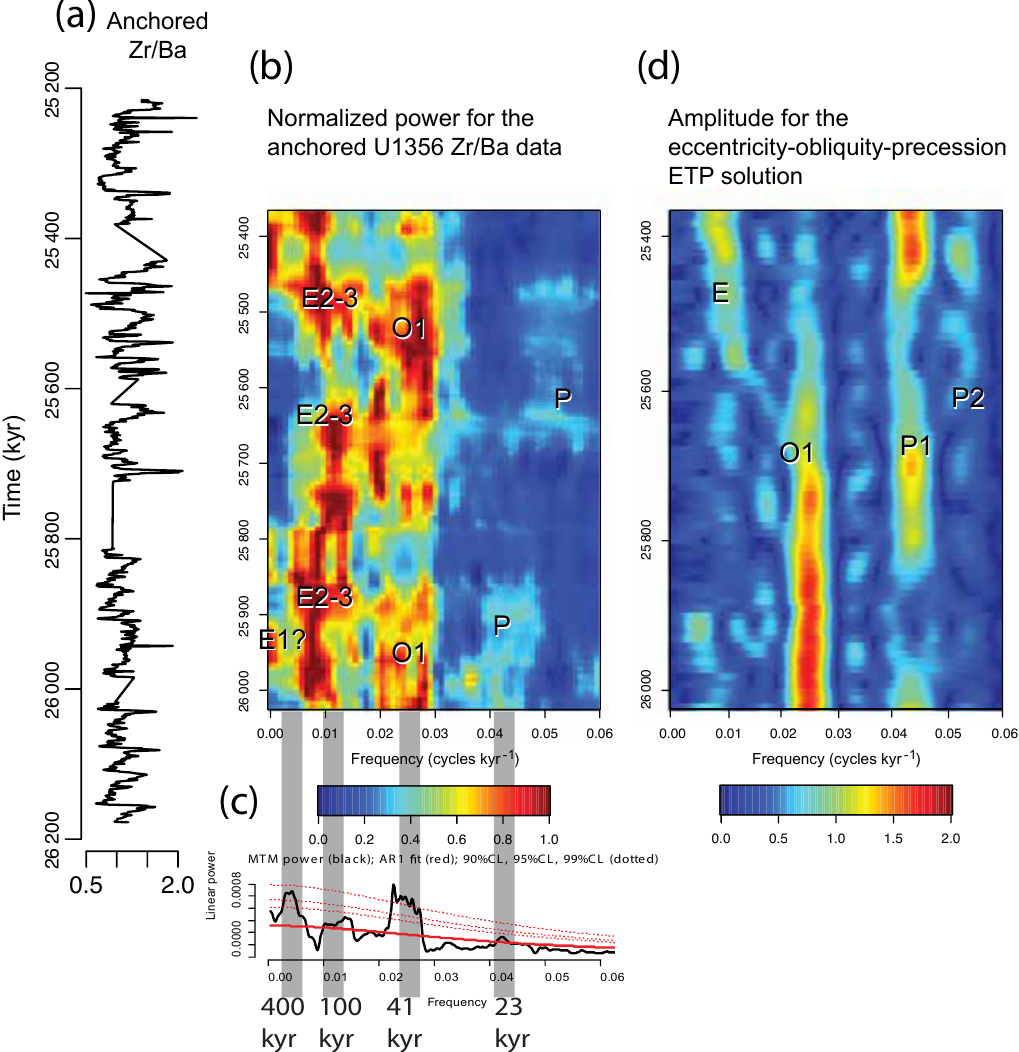
Figure 6. Spectral analysis results of the Zr / Ba obliquity tuned and anchored data. (a) Zr / Ba ratio tuned with Astrochron (Meyers, 2014) and anchored to the top of the C8n.2n ( o ) chron. (b) EHA and (c) MTM spectral analysis on Zr / Ba tuned data. EHA normalized power with 300kyr window with discrete prolate spheroidal sequence (DPSS) tapers. (d) EHA amplitude for the eccentricity, obliquity (tilt), and precession (ETP) solution (Laskar et al., 2004) calculated for the same period of time with 3DPSS tapers and 200kyr